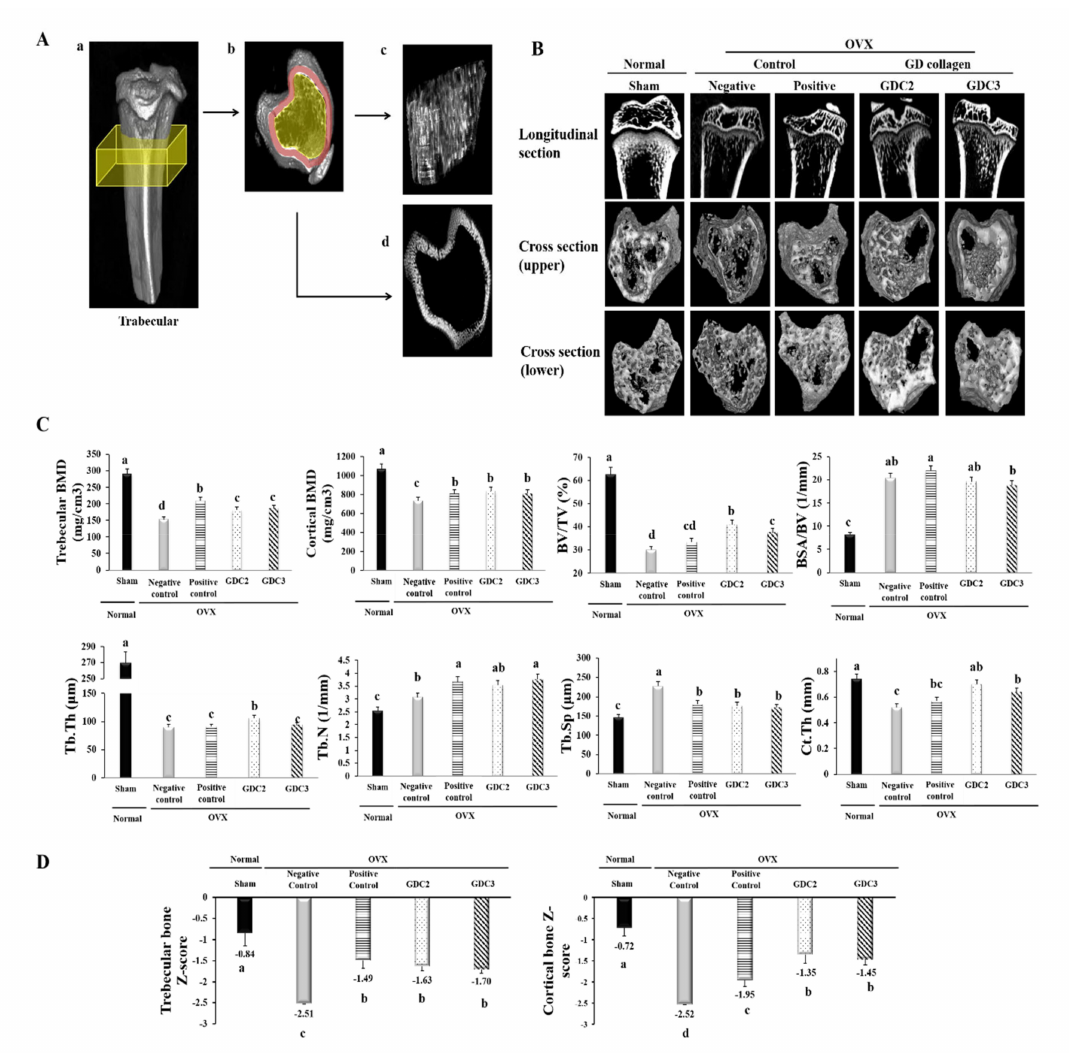
Figure 5. Tibial bone microstructure analysis in OVX rats. ( A ) Surface renderings show the regions used for the ex vivo analysis (yellow boxes) of the trabecular bone. (a) Shows the trabecular cross-section of the slab. (c) Shows representative isosurfaces taken from the yellow region indicated in (b). (d) Shows the surface of the cortical bone from a representative rat, which was used for cortical analysis within the red region indicated in (b). ( B ) Longitudinal section and cross-section of the trabecular bone. ( C )